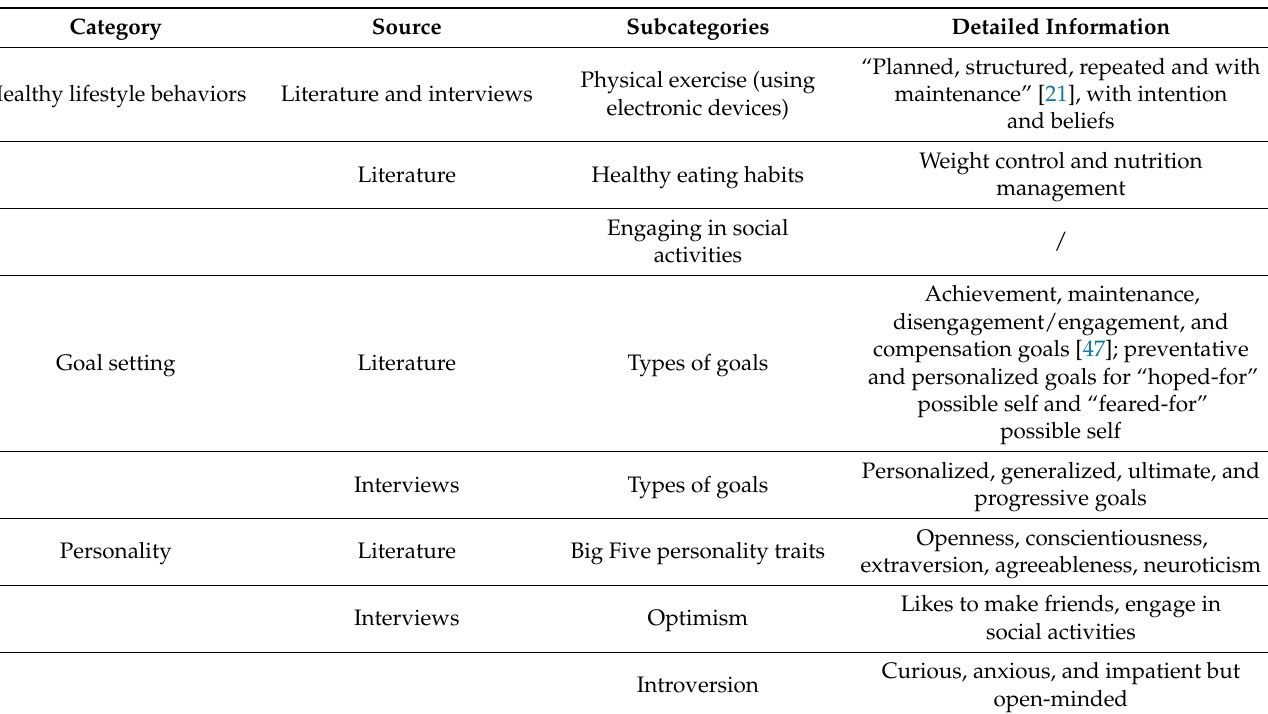
Table 2. Summary of categories and coding for literature synthesis and